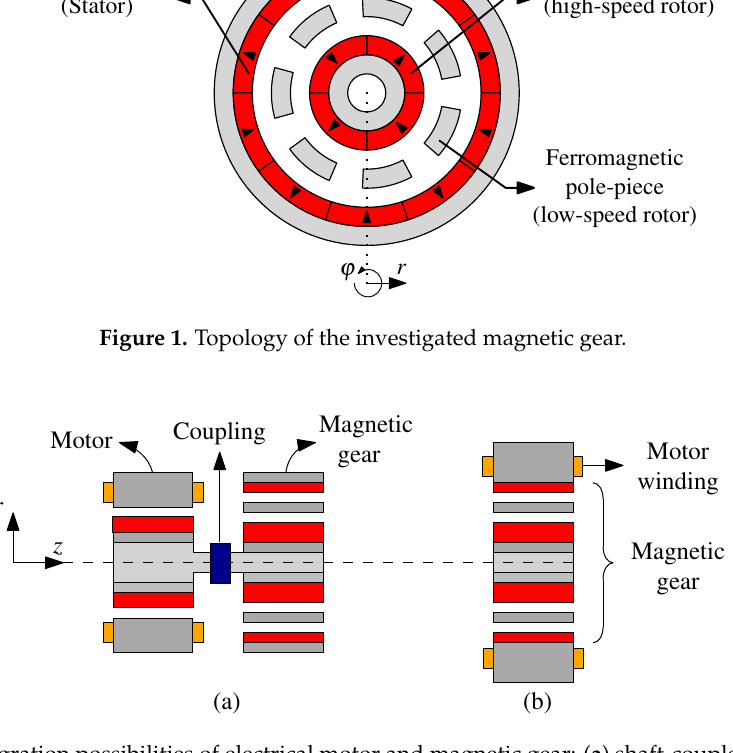
Figure 2. Integration possibilities of electrical motor and magnetic gear: ( a ) shaft-coupled motor and gear; ( b ) “pseudo” direct-drive